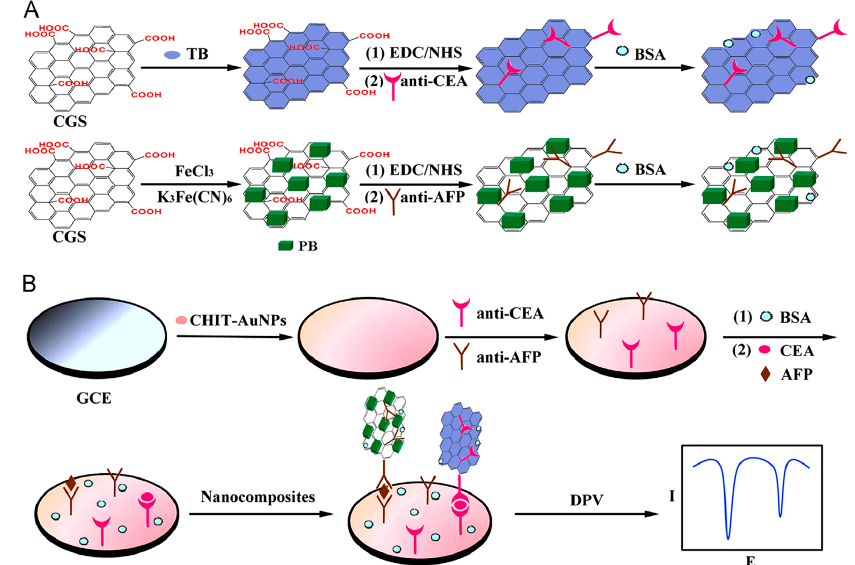
Figure 8. Schematic illustration of: ( A ) the preparation of biofunctional carboxyl graphene nanosheets (CGS) nanocomposites with toluidine blue (TB) or Prussian blue prepared from FeCl 3 and K 3 Fe(CN) 6 and ( B ) the multiplexed electrochemical immunoassay protocol for determination of CEA and α -fetoprotein (AFP). Reprinted from [60] with permission.